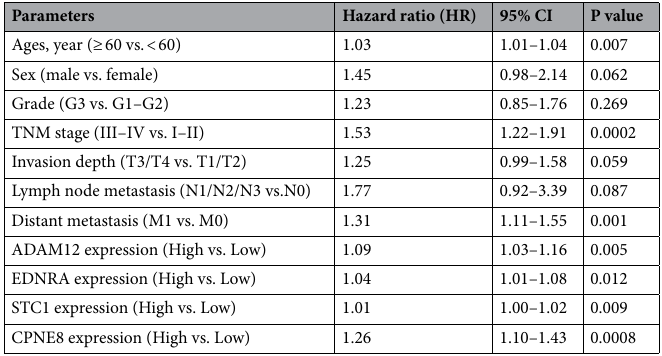
Table 2. Univariate analysis of prognostic factors in patients with GC using Cox regression